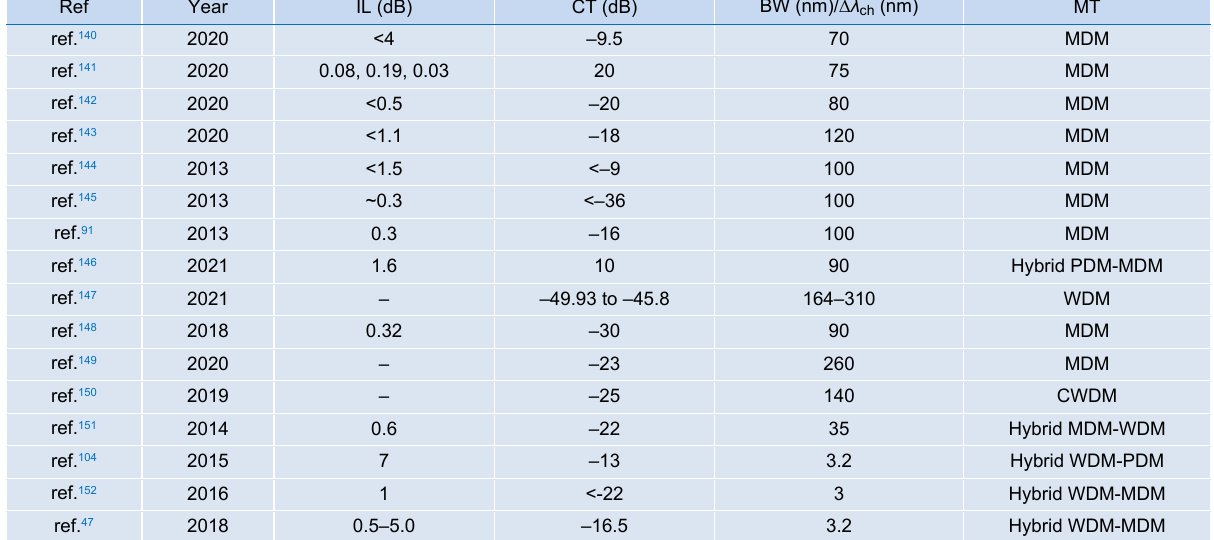
Table 1 | Few major optical multiplexing papers reported in recent times. IL: Insertion loss, CT: Crosstalk, BW: Bandwidth, MT: Multiplexing